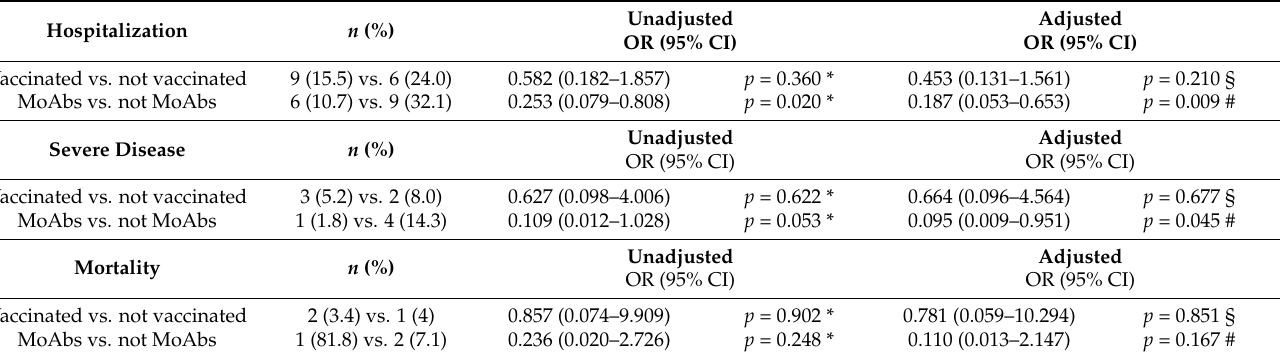
Table 2. Impact of Vaccination and MoAbs administration on COVID-19 course during the second year of pandemic (84 SARS-CoV-2-infected PADs